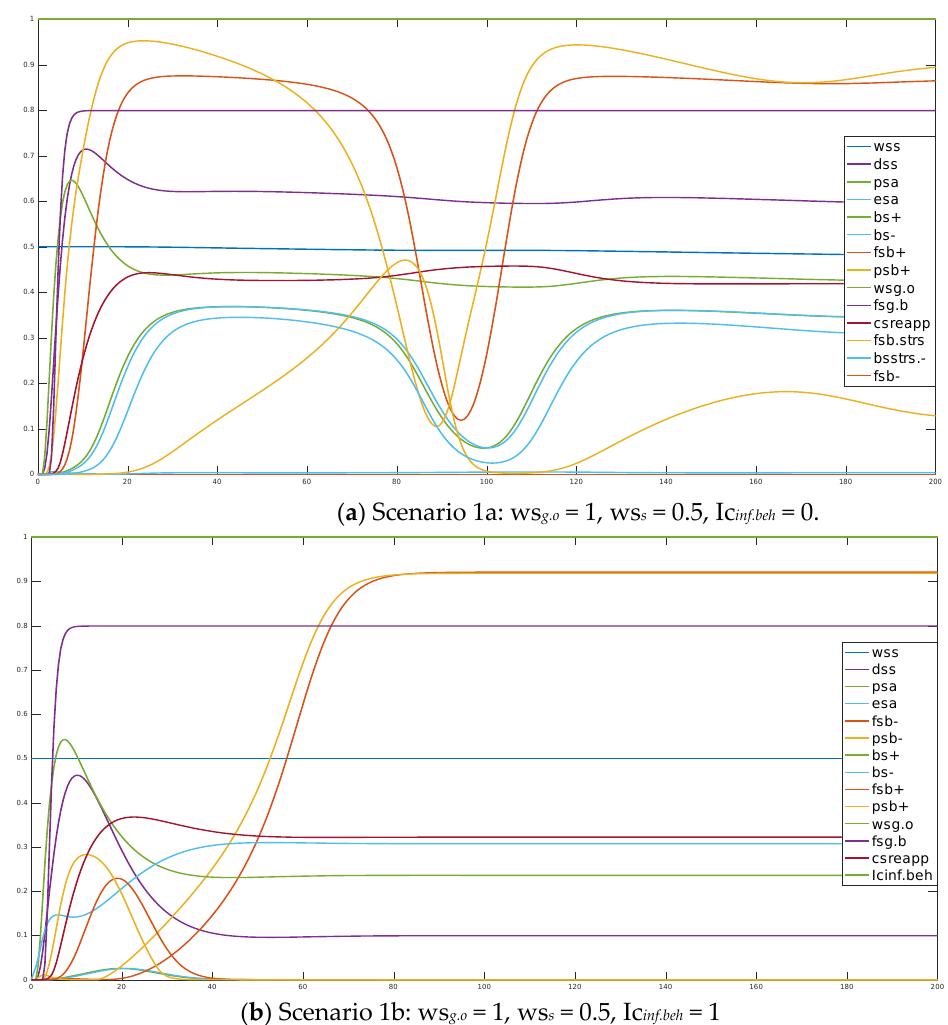
Figure 2. ( a ) Failure of reappraisal in the absence of information on health consequences. ( b ) Successful reappraisal of food desires after providing information on health consequences as an intervention.